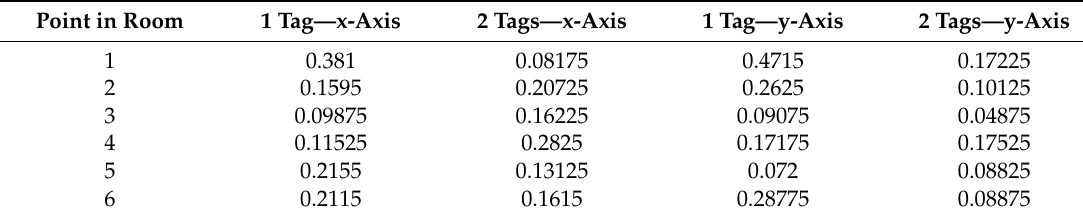
Figure 11. Office layout and points selected for measurements. Table 1. Average accuracy errors for one and two tags (in meters).